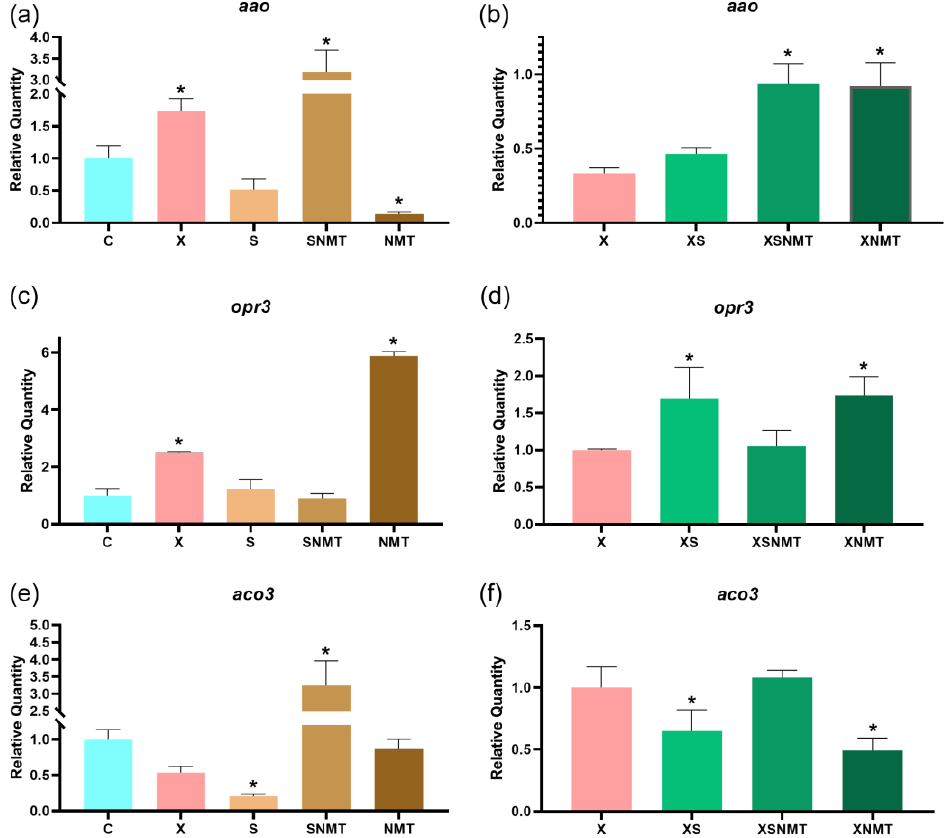
Figure 5. Expression levels of genes related to the ABA ( aao ), JA ( opr3 ) and ethylene ( aco3 ) pathways in tomato shoots, quantified by RT-qPCR. ( a , c , e ) represent the levels on uninfected/treated groups, and the positive control (X), compared to the negative control (C); ( b , d , f ) stand for the levels of infected/treated groups compared to the positive control (X). All values are presented as mean ± SD ( n = 3). Values marked with an asterisk are statistically different according to the Dunnett comparison test ( p < 0.05). C: uninfected untreated shoots; X: infected untreated shoots; S: uninfected shoots treated with Satureja montana EO; SNMT: uninfected shoots treated with Satureja montana EO + NMT formulation; NMT: uninfected shoots treated with NMT; XS: infected shoots treated with Satureja montana EO; XSNMT: infected shoots treated with Satureja montana EO + NMT formulation; XNMT: infected shoots treated with